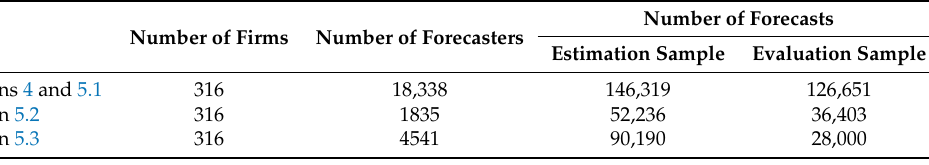
Table 1. The number of firms, forecasters and forecasts for each upcoming section and subsection. The number of forecasts is shown separately for the estimation sample, which is up until 2005, and the evaluation sample, which is from 2006